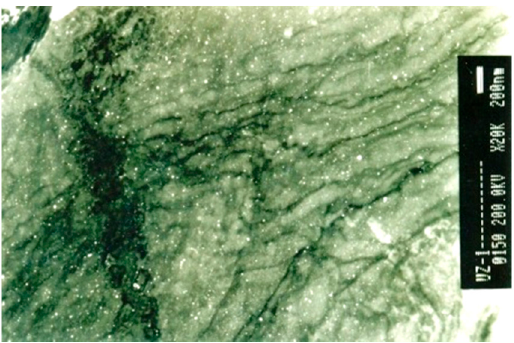
Figure 3. TEM micrograph of niobium precipitates in pre-deformation, reproduced from [10], with permission from Taylor&Francis, 2013.